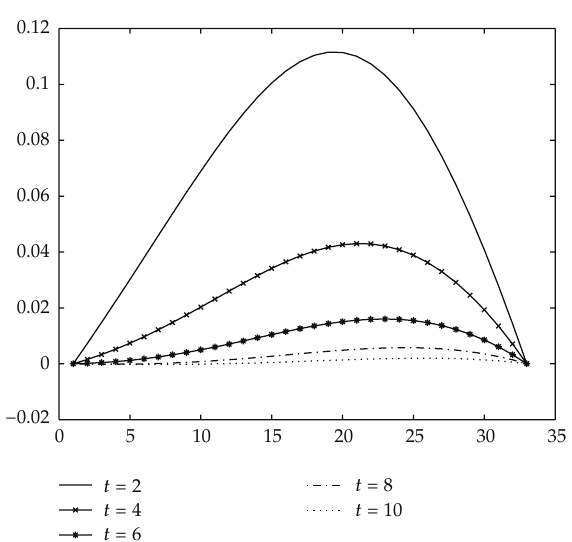
Figure 2: Numerical solution of u (cid:4) x,t (cid:5) with h (cid:9) 0 . 03125 ,τ (cid:9) 0 . 1 when p (cid:9)